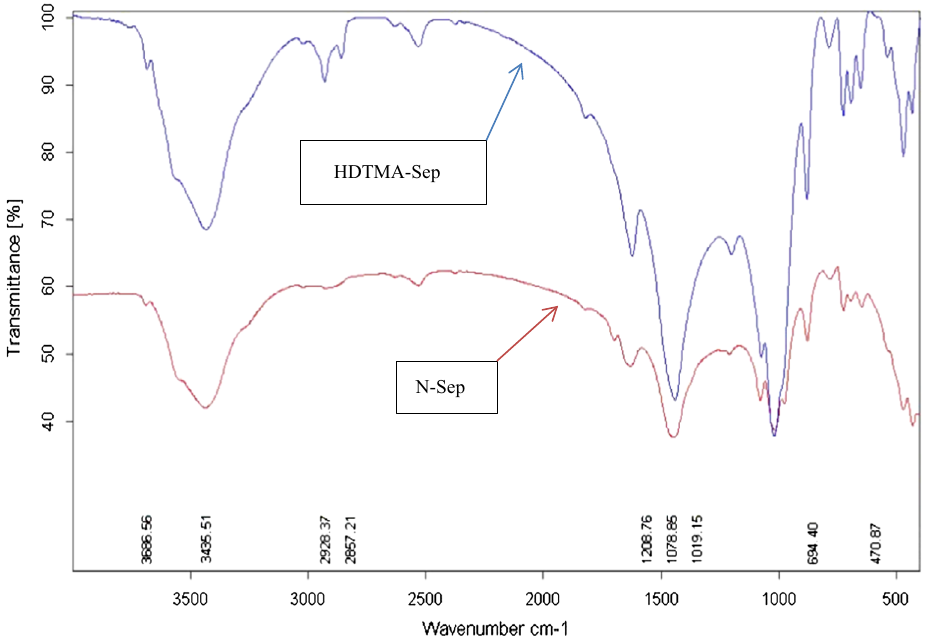
Fig. 1 FTIR spectra of N-Sep and HDTMA-Sep